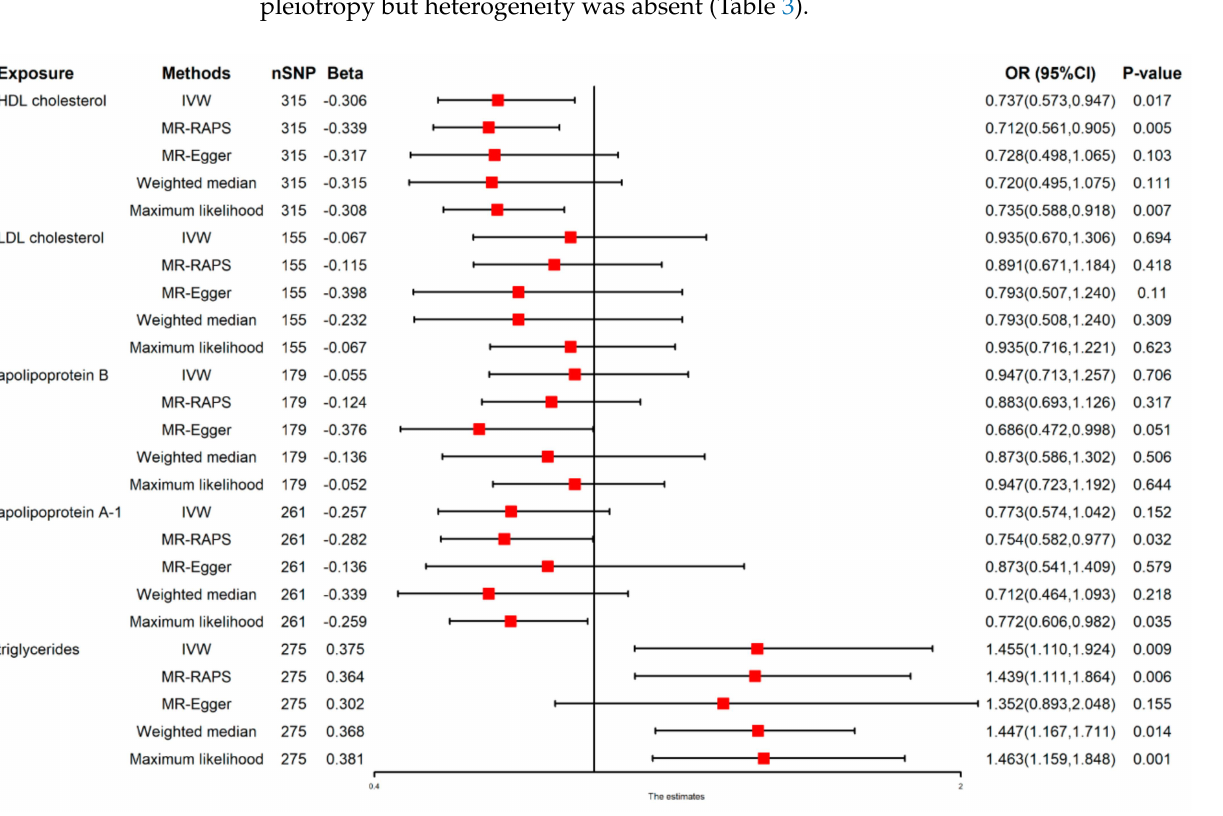
Figure 1. Causal effect of lipids on NAFLD. The red point means the effect (Beta). Table 2. MR-PRESSO estimates between exposures and